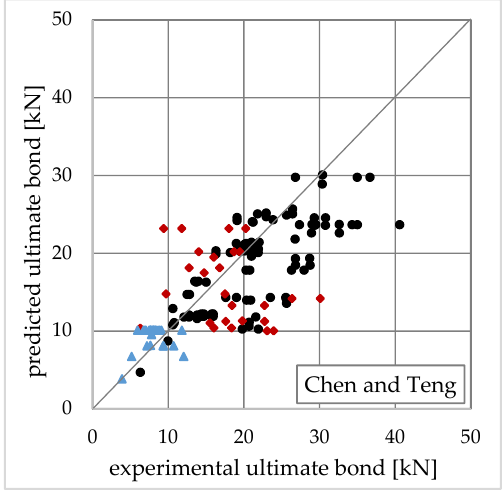
Figure 16. Test vs. predicted bond force using the Chen and Teng model [28].